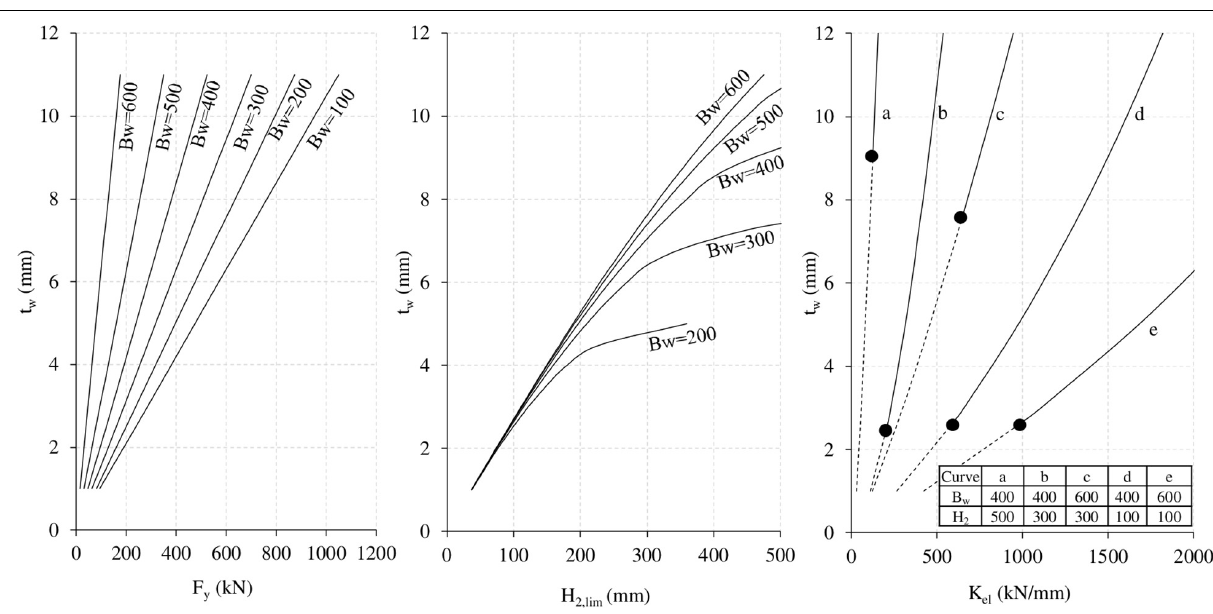
lines correspond to geometrical combinations which generate buckling, whereas the continuous lines represent suitable